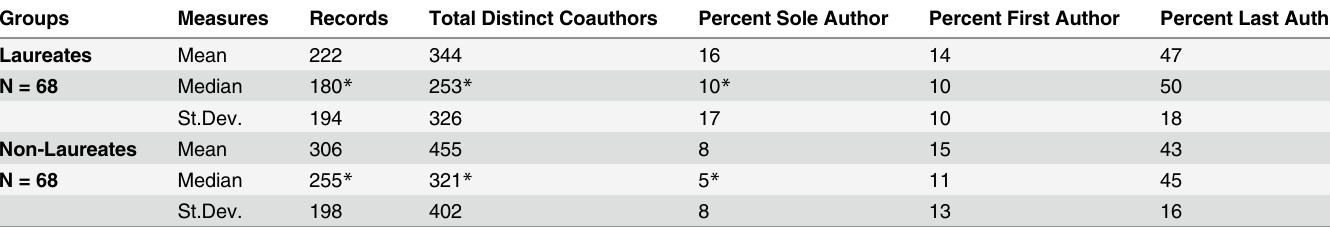
Table 1. Descriptive Statistics at Author Level for Laureates and Non-Laureates.